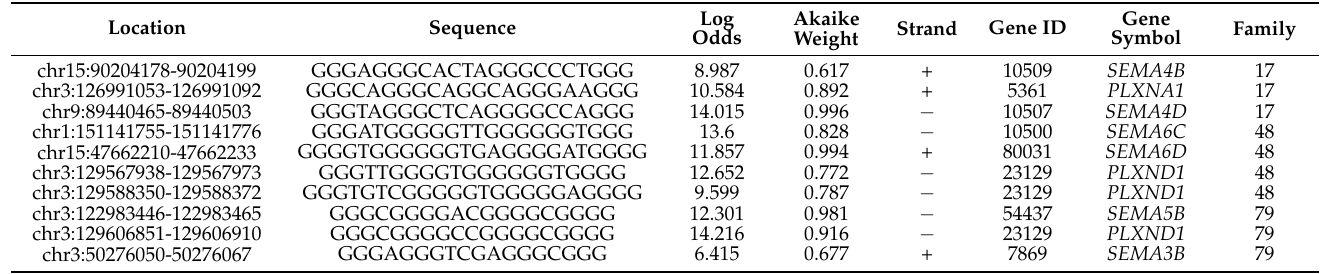
Table 3. G4 sequences identified in the genic regions associated with the plexin and semaphorin gene families with high similarity to G4 Families 17, 48, and